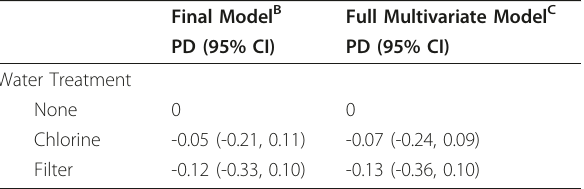
Table 3 Prevalence differences for the relationship between water treatment method and diarrheal disease A in the North Atlantic Autonomous Region, Nicaragua, 2009.